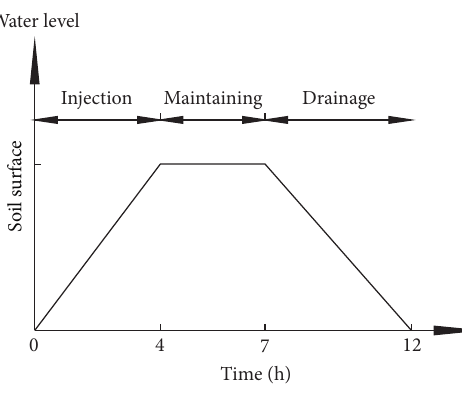
Figure 3: Schedule